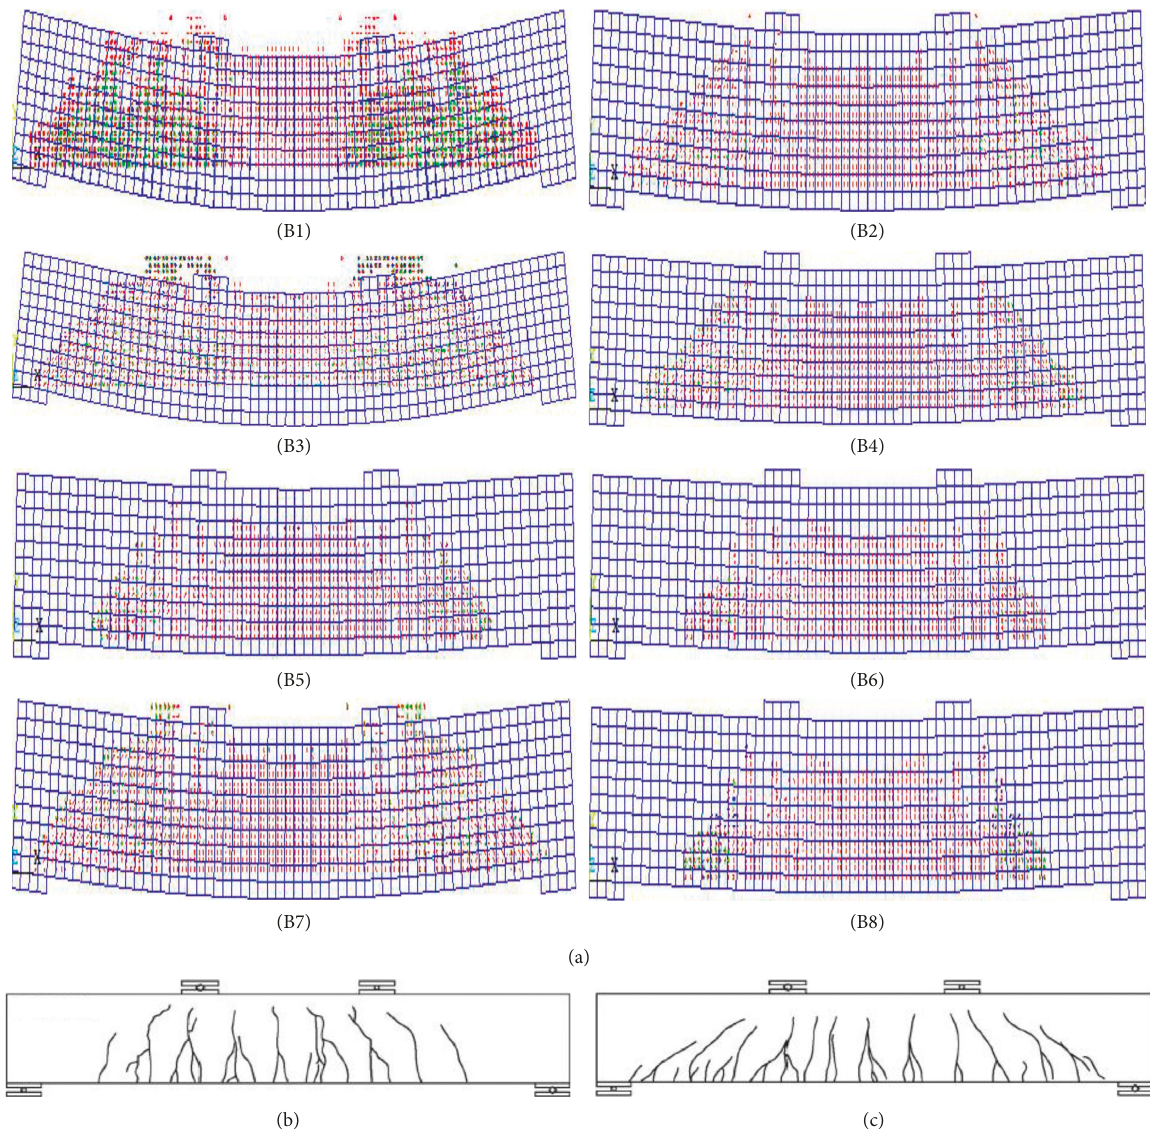
Figure 20: (a) Crack patterns and the failure modes at the end of test for all models, (b) crack patterns for B1 from experimental test [11], and (c) cracks patterns for B2 from experimental test